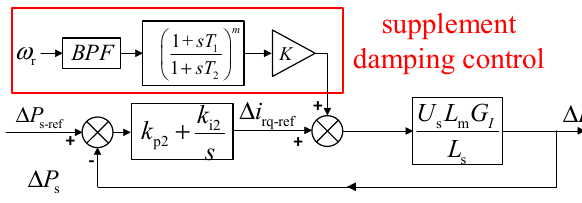
Figure 3. Control diagram of DFIG stator active power.